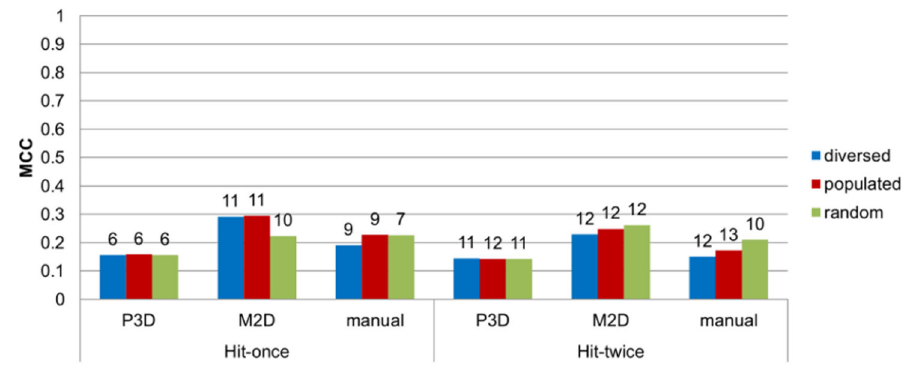
Figure 6. The MCC results for the validation of the top linear combinations. The MCC results for the validation of the top linear combinations. The length of combination is shown on top of the bars.